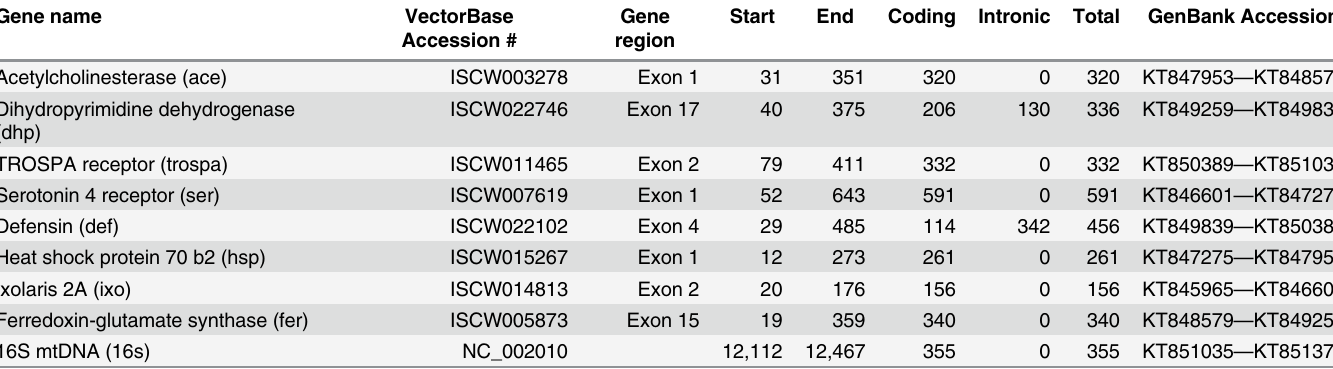
Table 1. Gene name, GenBank and VectorBase accession number for each of the 8 nuclear Ixodes scapularis genes and the accession number for the 16S gene. Under each gene name are listed the region of the gene examined, the length of that region, the GenBank accession number and the Vector- Base coordinates for the beginning and end of each sequence. The numbers of nucleotides in coding versus intronic regions are